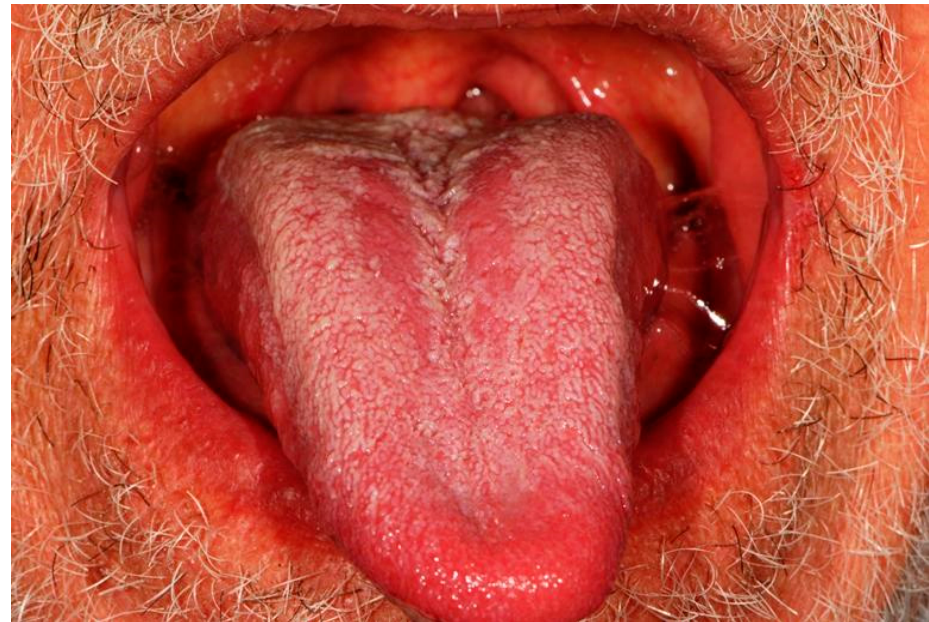
Figure 3. Atrophic area of dorsal tongue associated with median rhomboid glossitis (Patient no. 4, Table 2).